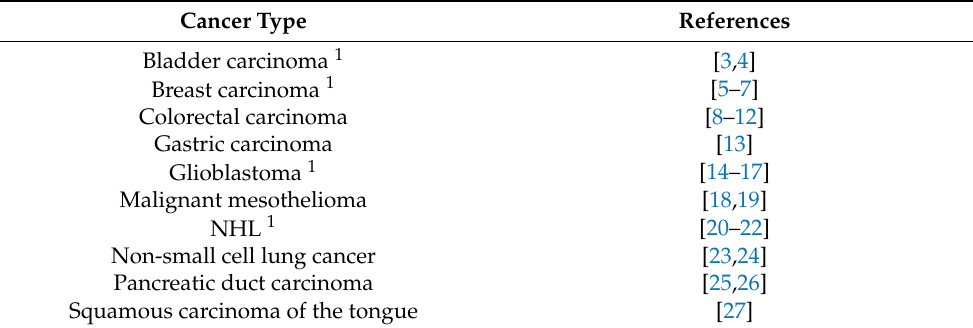
Table 1. Examples illustrating the diversity of human cancers in which apoptosis in situ correlates with poor prognosis.